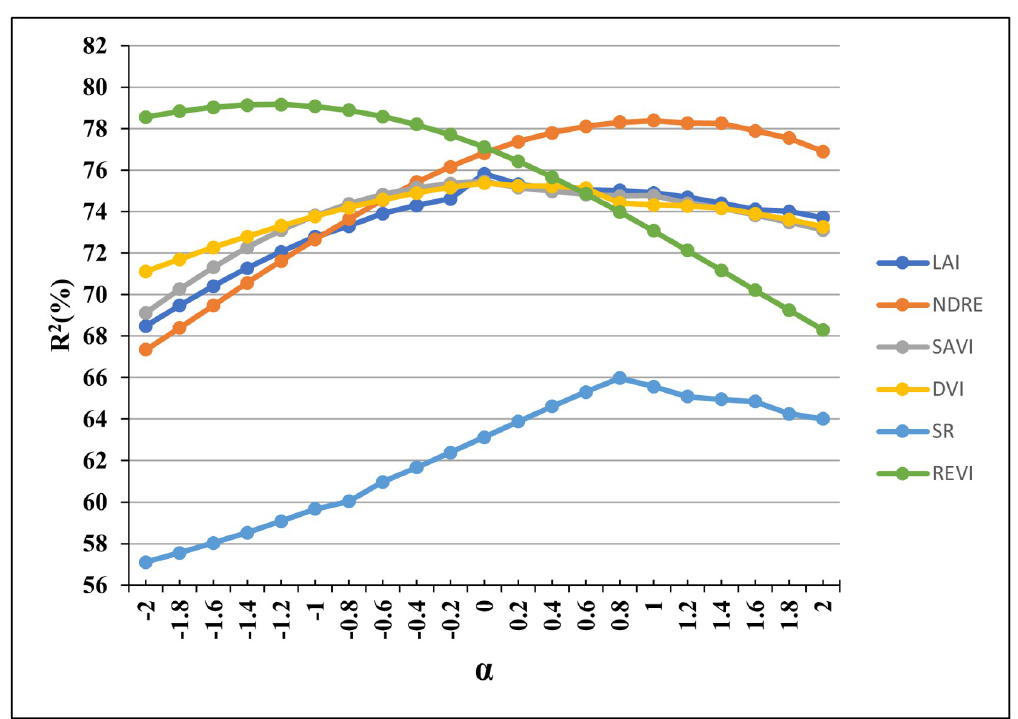
Fig 9. The convergence curve for the optimal value of the parameter ( α ) in MI-formula for six selected Vegetation Indices (VI).